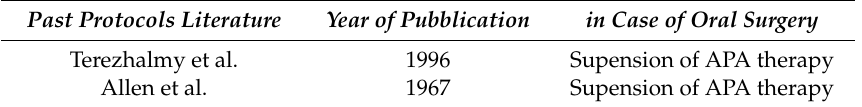
Table 2. Past protocol